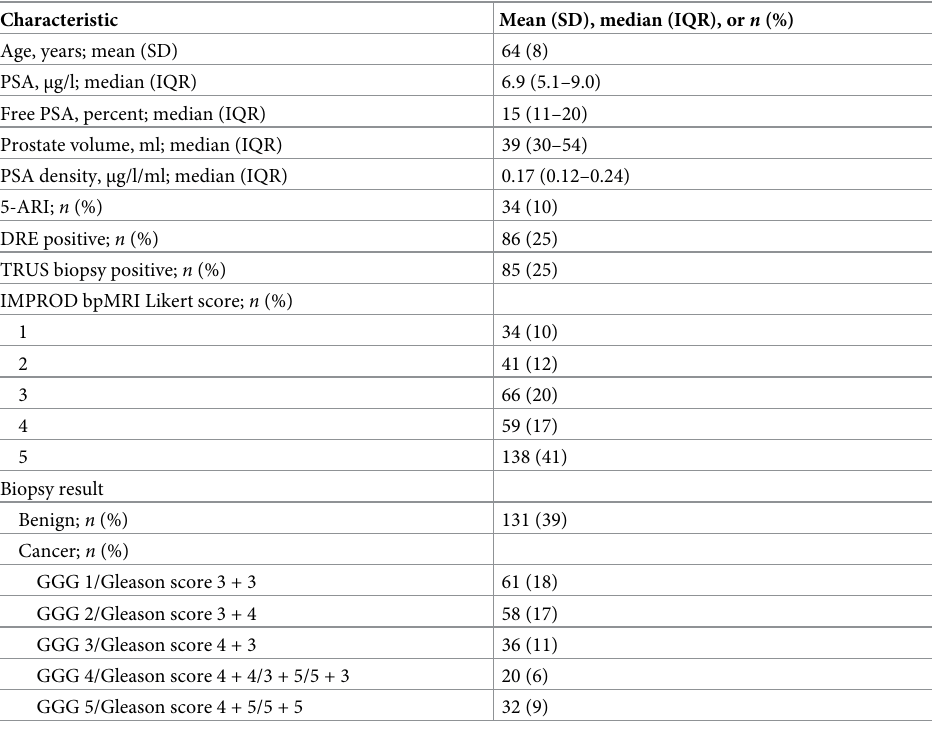
5-ARI, 5 -alpha reductase inhibitor; bpMRI, biparametric magnetic resonance imaging; DRE, digital rectal antigen; TRUS, transrectal